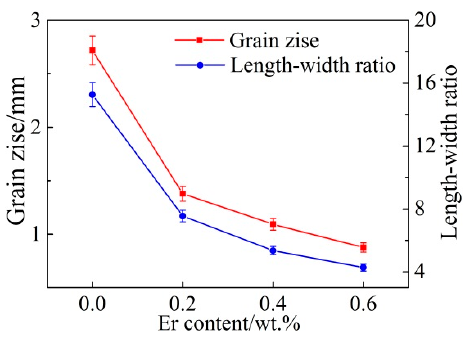
Figure 7. Refinement effect of Er addition on prior β grains size and the ratio of length to width of α lath.